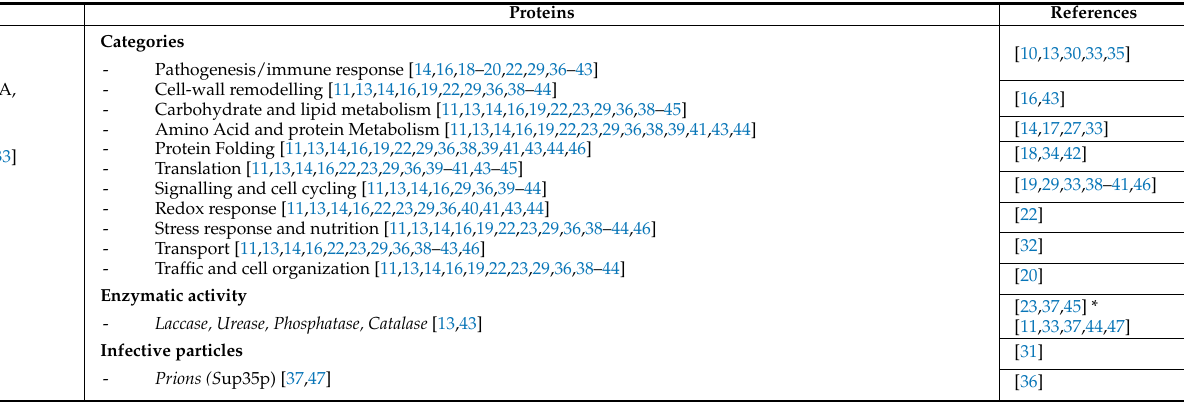
Table 1. Protein and nucleic acid composition of EVs in